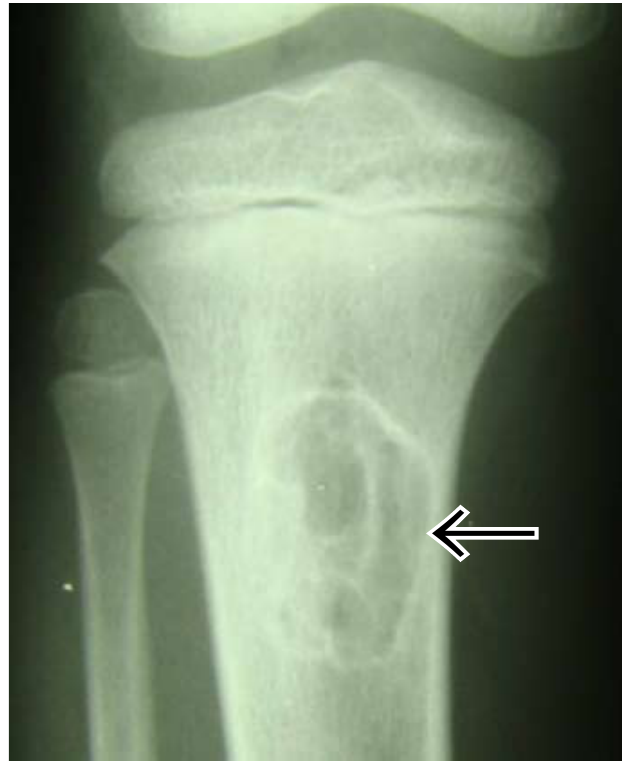
→ → Fig. 14b. Anteroposterior radiograph of the knee with intraosseous neurofi- broma of the proximal tibia. Fig. 14a. Anteroposterior X-ray of the proximal tibia and fibula demonstrating endosteal sclerosis of the tibia and an intraosseous neurofibroma of the fibula with associated soft-tissue mass.